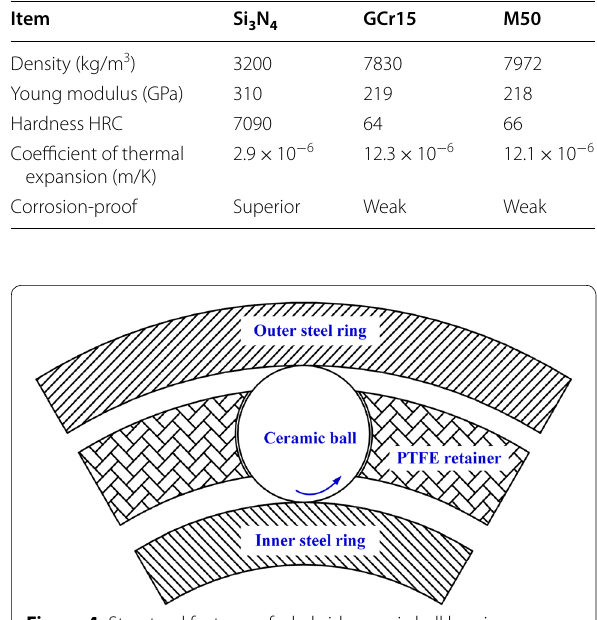
Table 1 Mechanical performance of Si